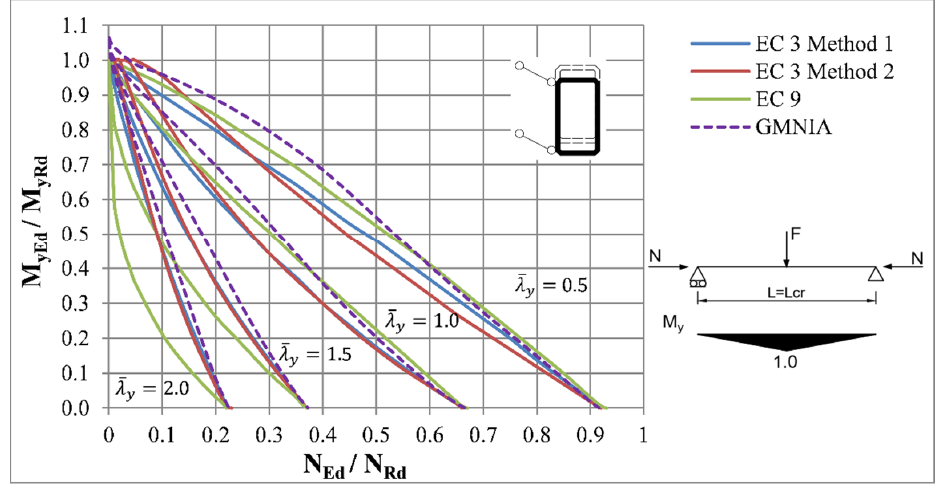
Figure 36. Interaction curves for laterally restrained beam-columns with RHS cross-section.